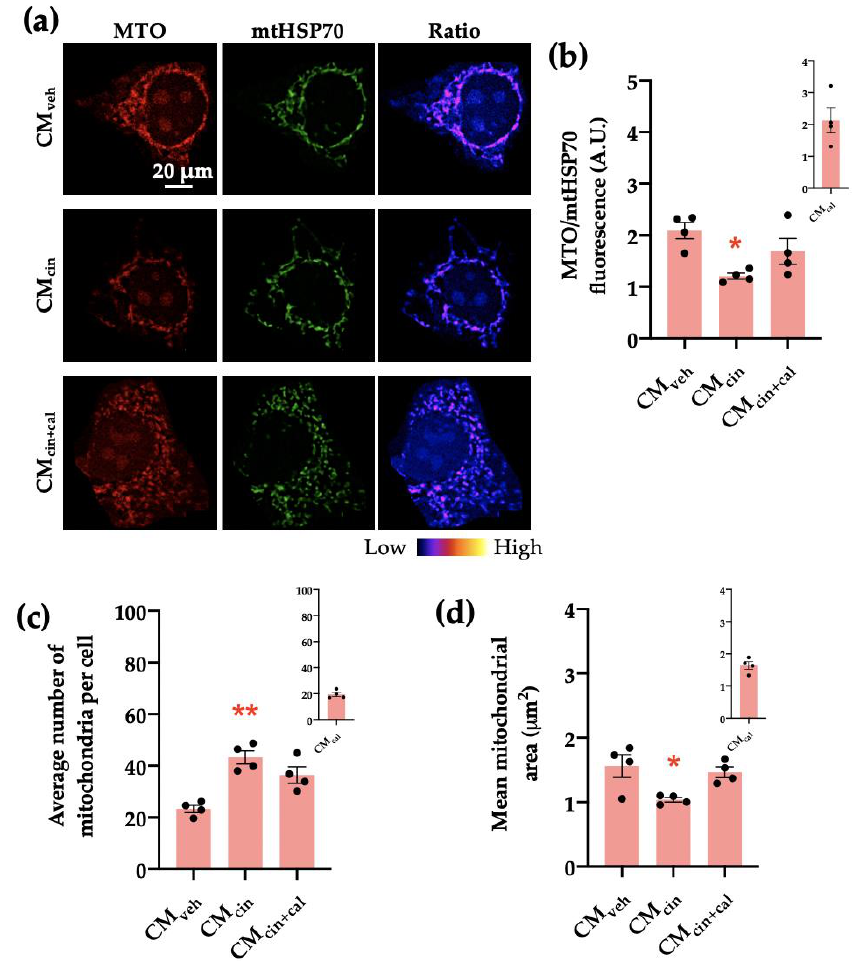
Figure 7. CaSR activation in SW872 pre-adipocytes induces the secretion of factors that induce mitochondrial alterations in HepG2 cells: ( a ) representative immunofluorescence images obtained through confocal microscopy of HepG2 cells treated with CM veh , CM cin , or CM cin+cal stained with MitoTracker Orange (MTO, red) and an anti-mtHsp70 antibody (green); the ratio of MTO/mtHSP70 fluorescence is shown in pseudo colors (right column of images); ( b ) quantification of the overall fluorescence ratios between MTO mtHsp70; ( c ) quantification of the mean mitochondrial area; ( d ) quantification of the average number of mitochondria per cell. The insets show CM cal levels relative to the control. Each dot represents an individual experiment ( n = 4). * p < 0.05 and ** p < 0.01 versus the control, Friedman ’ s test, and Dunn ’ s post-hoc test.